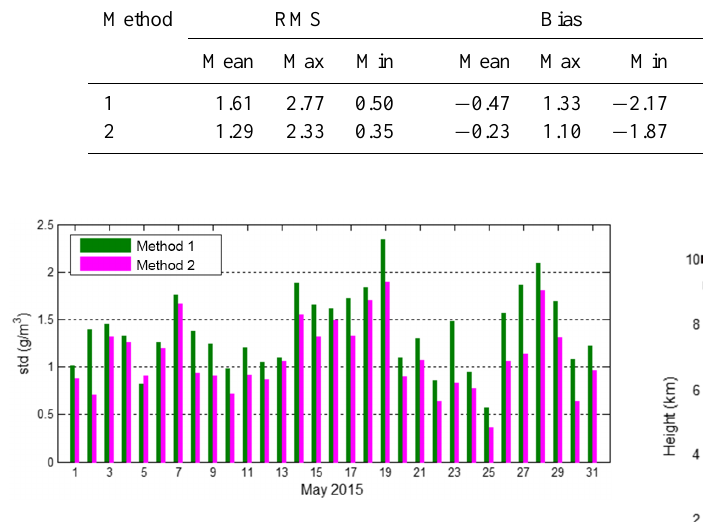
Figure 12. SD comparison for two methods from 1 to 31 May 2015.